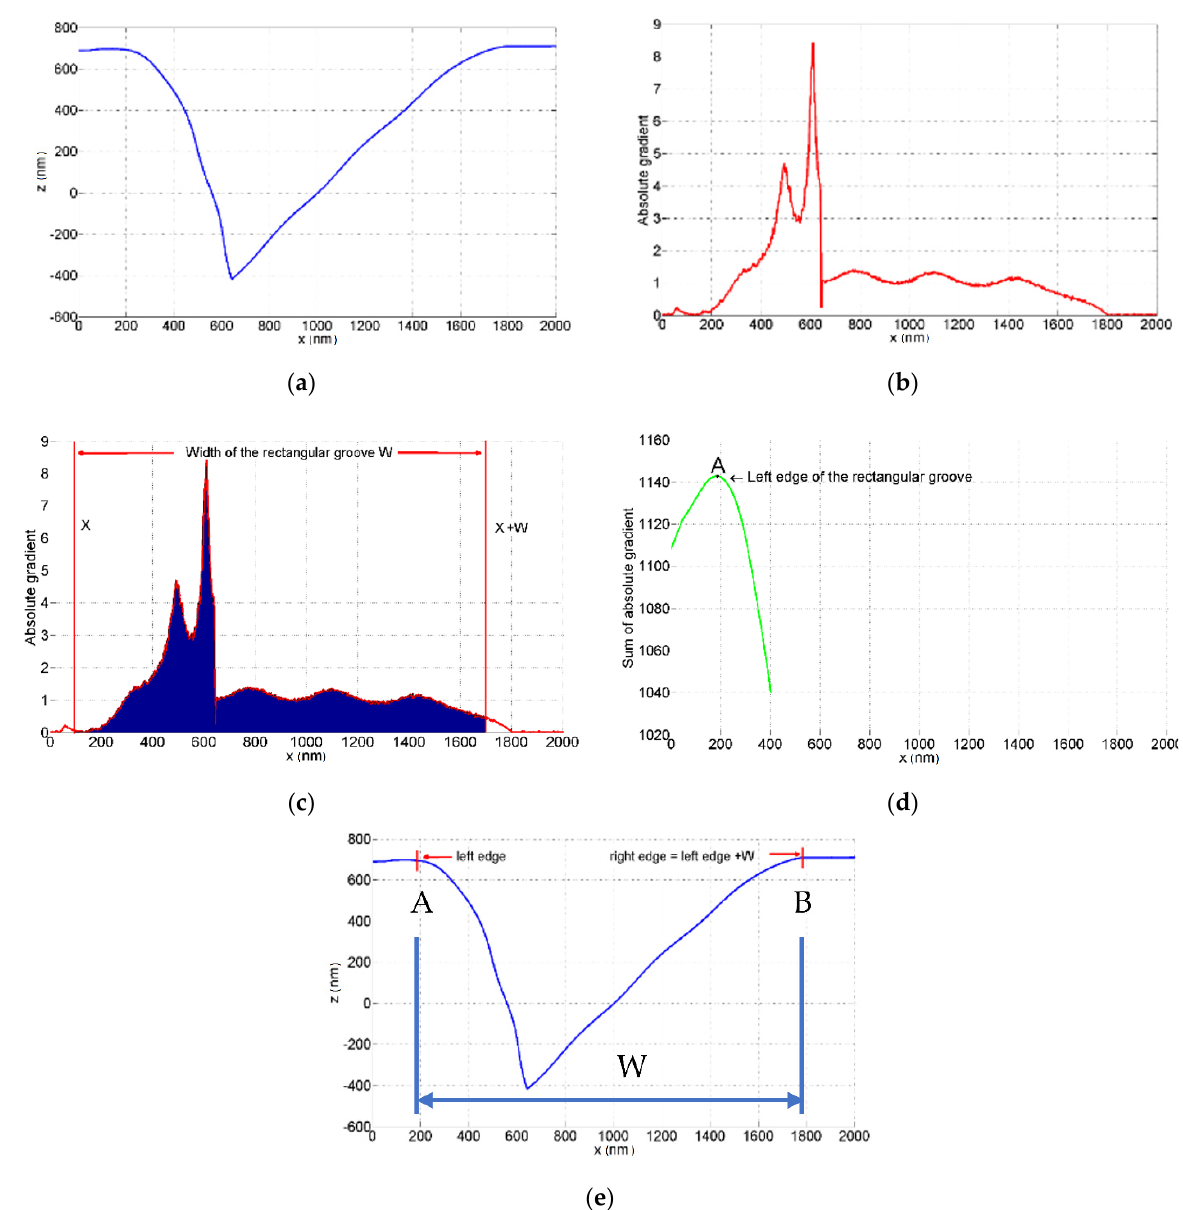
Figure 6. The structure width method is used to locate the ridge edges of the measured profile. ( a ) Measured profile of the rectangular groove structure after first-order leveling on ridge tops; ( b ) the absolute gradients of the profile | gr ( x )|; ( c ) the sum of absolute gradients from x to x + W 𝐺𝑅(cid:4666)𝑥(cid:4667) = ∑ |𝑔𝑟(cid:4666)𝑥(cid:4667)| (cid:3051)(cid:2878)(cid:3024) (cid:3051) (shaded area); ( d ) ridge edge A is the position with the maximal GR value; ( e ) ridge edge B is W away from ridge edge A.